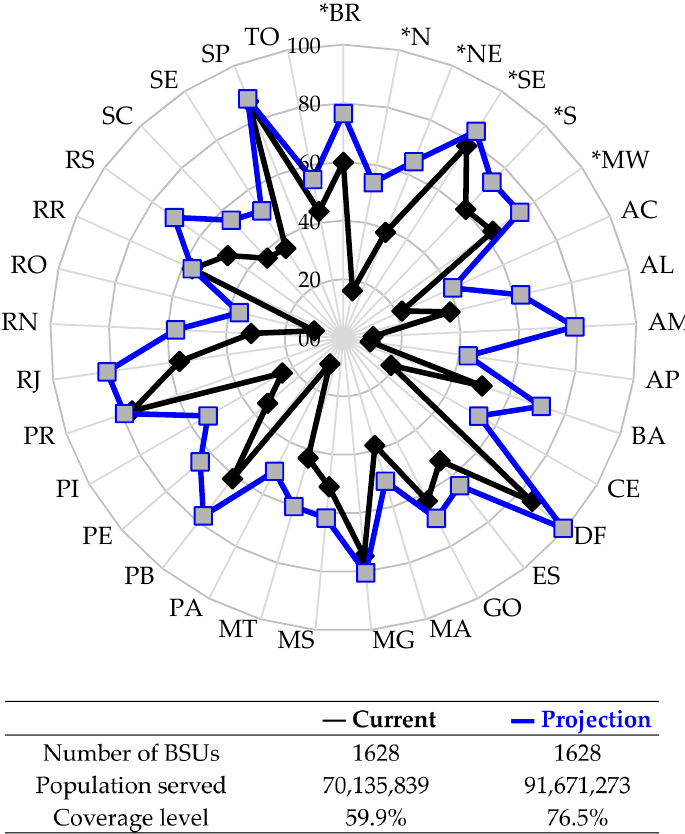
Figure 7. Percentage of the population served with water and sewage, considering the estimated efficiency gains within the final sample in relation to the current level of efficiency. Results by federative units in Brazil and by Brazilian regions (*): BR = Brazil; N = North Region; NE = Northeast Region; SE = Southeast Region; S = South Region; MW = Midwest Region. Source: Author’s own elaboration based on the research result.